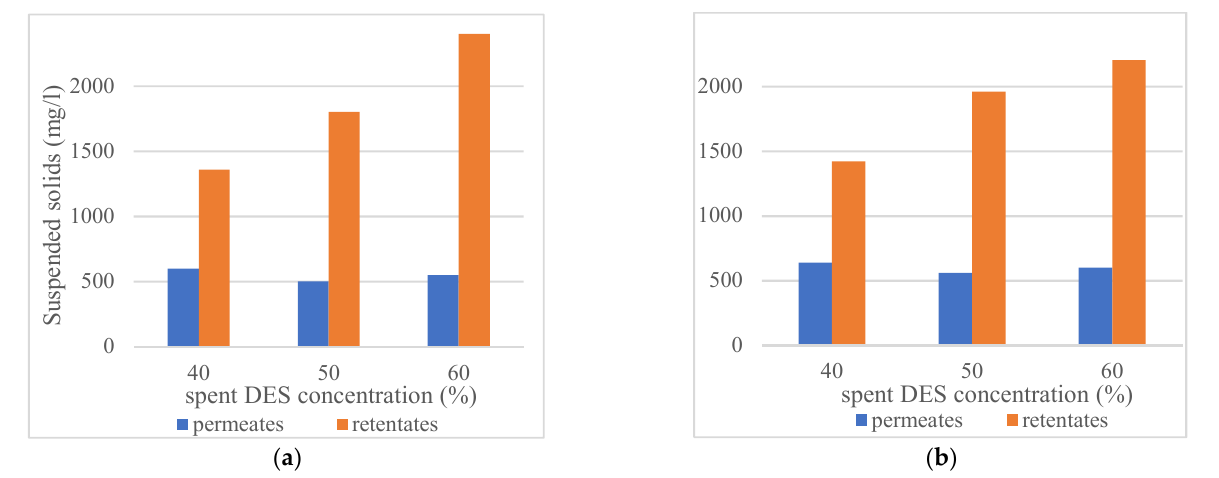
Figure 5. Suspended solids (hemicelluloses and lignin) in permeates and retentates of 40 vol%, 50 vol% and 60 vol% spent DES solutions after anti-solvent precipitation (RC70PP membrane, Amicon cell unit, at 3.5 bar, 21 °C and 45 °C, 250 rpm, anti-solvent: DES ratio 9:1): ( a ) Ultrafiltration at 21 °C; ( b ) Ultrafiltration at 45 °C.